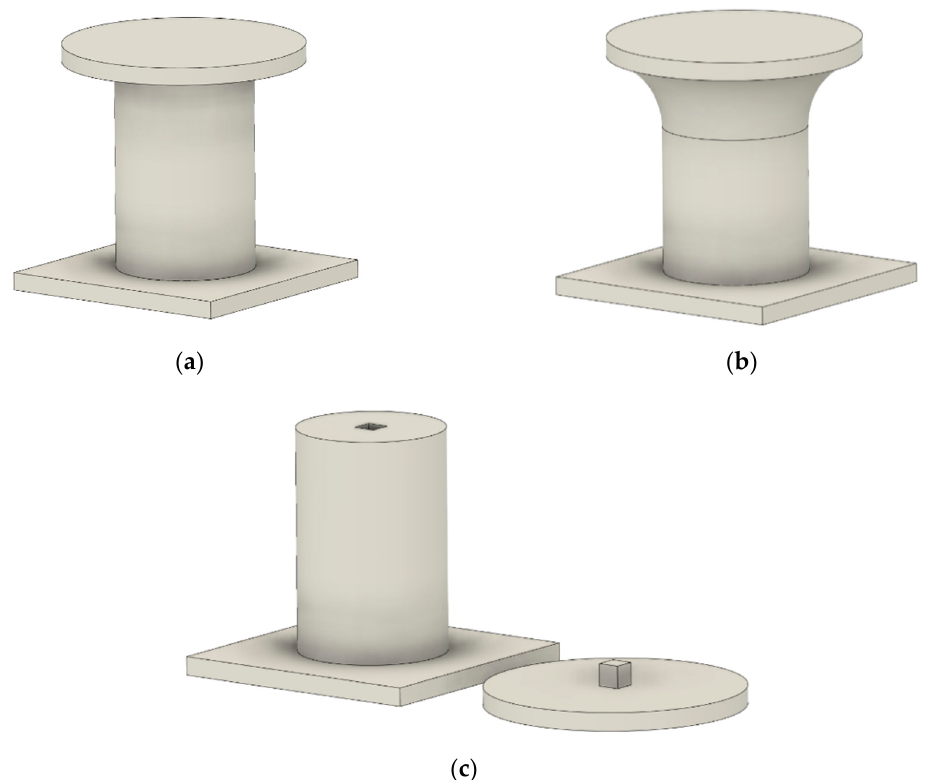
Figure 4. ( a ) Object with poor printability; ( b ) printable object filleting the floating area; ( c ) printable object splitting critical area from main body.